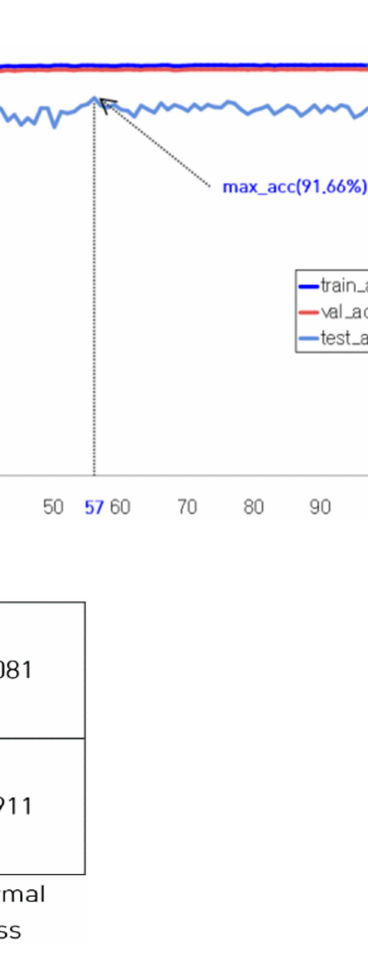
Figure 9. Confusion matrix for our model.